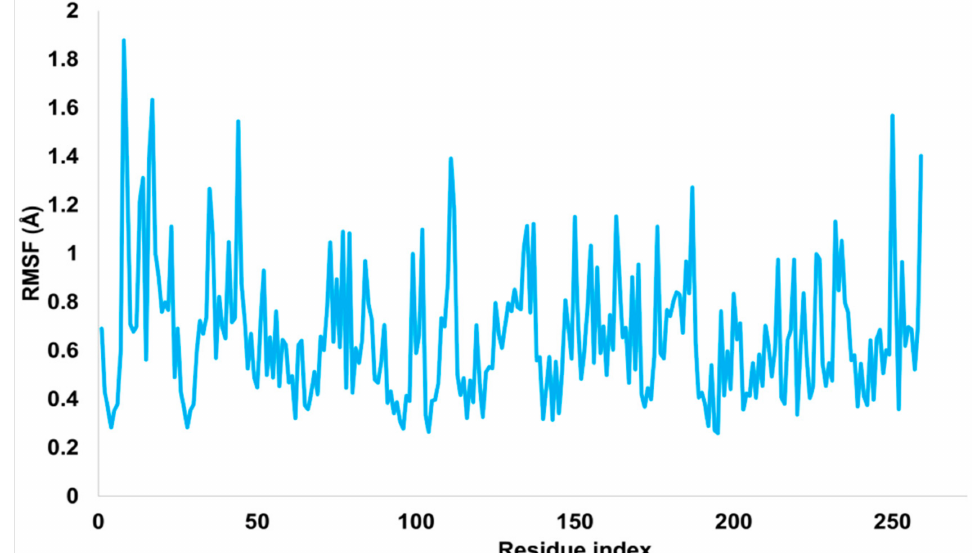
Figure 10. Root mean square fluctuations (RMSF) of Carbonic anhydrase